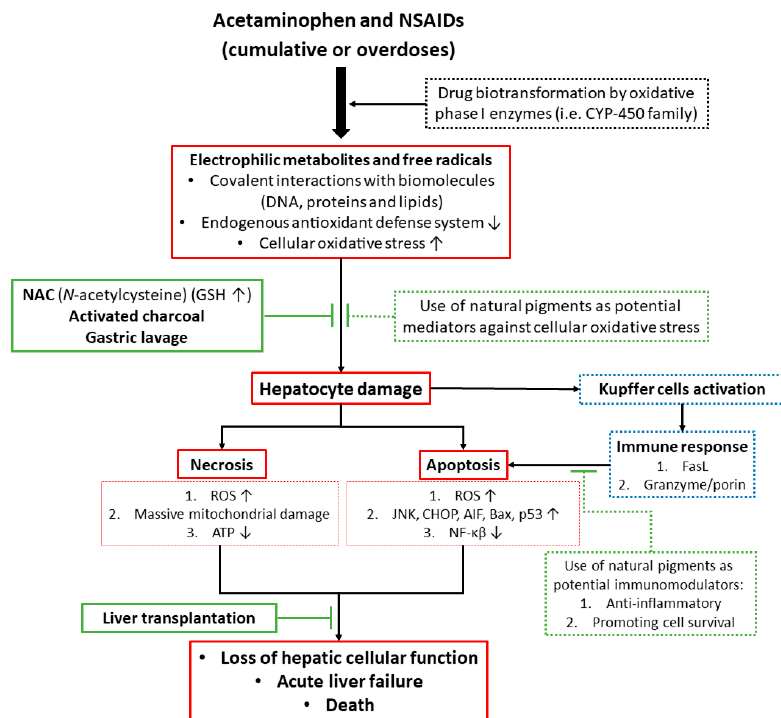
Figure 3. Biotransformation of drugs by oxidase enzymes triggers an intracellular chain reaction mediated by the overproduction of reactive metabolites and free radicals which leads to cell death. Current treatments for drug-induced liver injury are limited. Natural pigments represent a potential alternative treatment to prevent acute liver failure. CYP450, cytochrome P450; GSH, glutathione; ROS, reactive oxygen species; JNK, c-Jun N-terminal protein kinase; CHOP, C/EBP homologous protein; AIF, apoptosis-inducing factor; Bax, bcl-2-associated X protein.